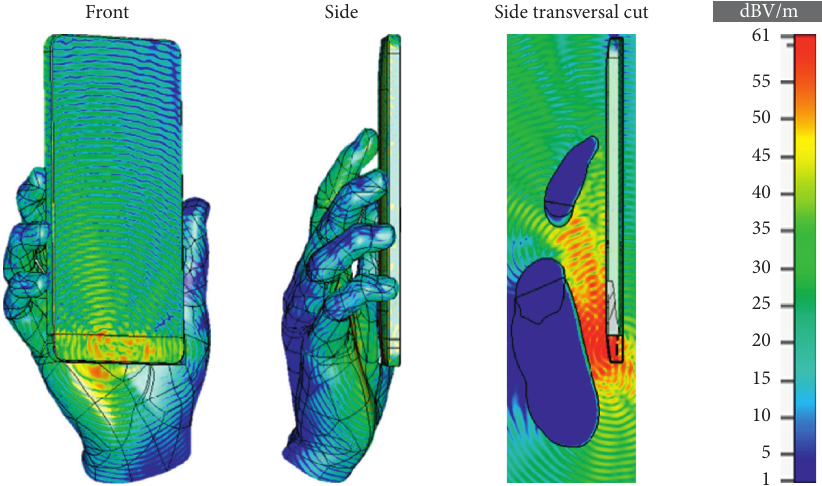
Figure 10: E-fields propagation contour plots for the PBS array integrated into the form factor with the hand